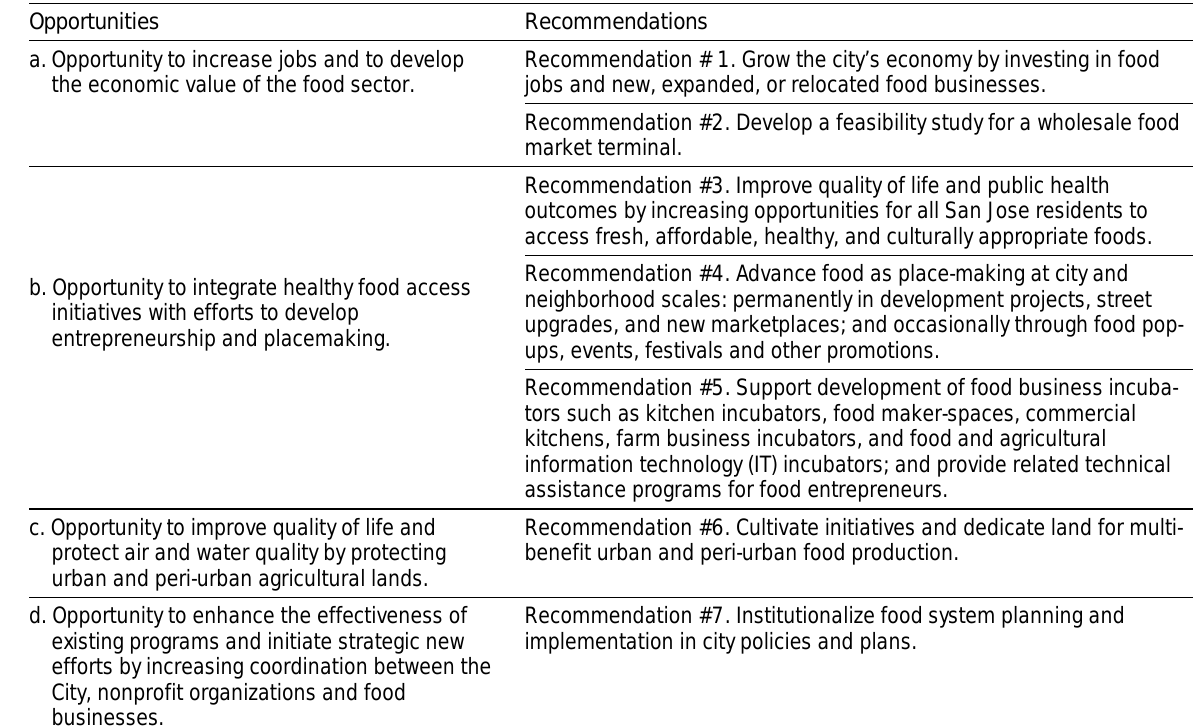
Table 6. Opportunities and Cross-cutting Recommendations Opportunities